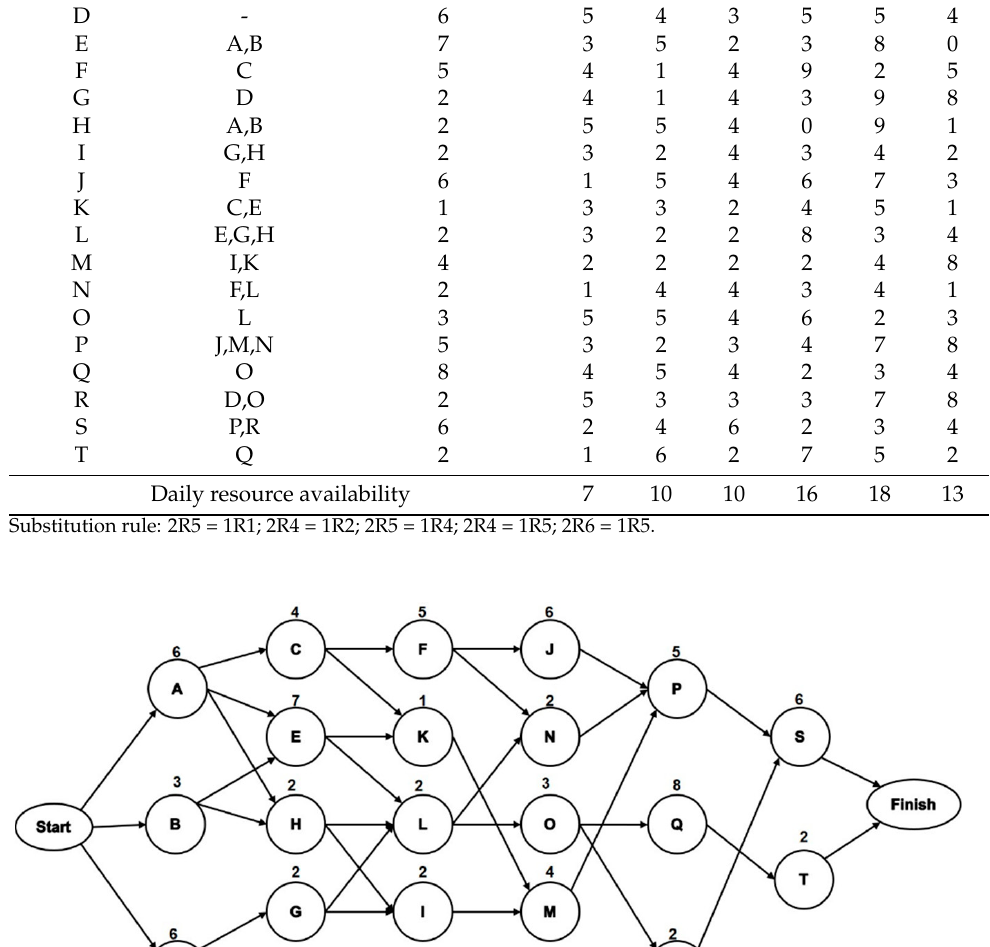
Figure 4. Network Diagram for Project C. Then, the SMSRS model results were validated through a comparison with results obtained from single-skilled resource scheduling (SSRS) software (RESCON) and the ex- isting deterministic MSRS model. RESCON is a resource-constrained scheduling educa- tional software based on a single-skilled resource strategy. Table 8 shows the schedule sum- mary results of the three projects based on SSRS software, MSRS, and SMSRS models. Next, the project delay and percentage delay for the projects were computed using Equation (3). The results are shown in Table 9; Table 10 with the summary depicted in Figure 5. Finally, the average percentage delay error for the three projects was computed as 10.50%. %𝐷 𝑖 (cid:3404) 𝑃 𝑖 (cid:3398) 𝑃 𝐵 𝑃 𝐵